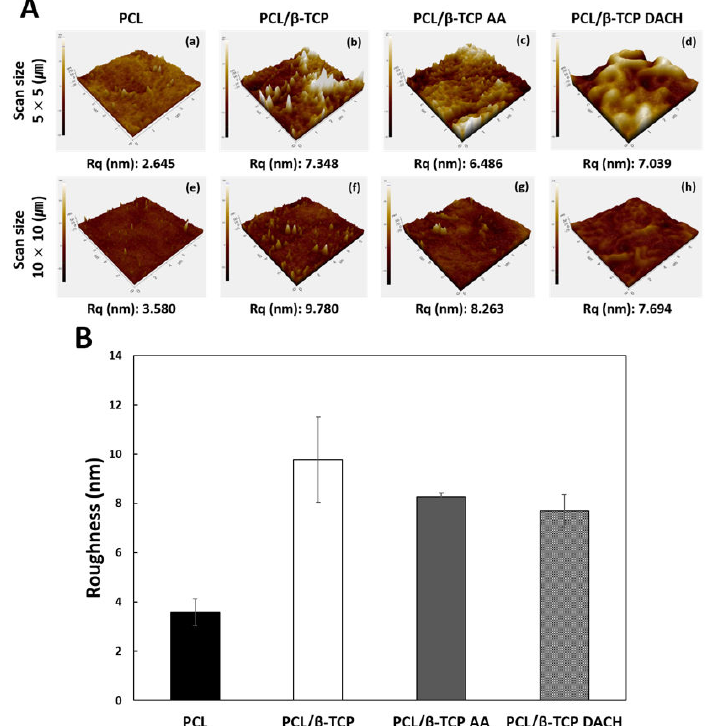
Figure 4. ( A ) Representative AFM 3D-topographical images of the ( a ) PCL scaffold, ( b ) PCL/ β -TCP scaffold, ( c ) PCL/ β -TCP scaffold treated by AA plasma for 1 min, ( d ) PCL/ β -TCP scaffold treated by DACH plasma for 1 min. For ( a – d ), the scan area = 5 × 5 µ m. For ( e – h ), the scan area = 10 × 10 µ m. ( B ) Roughness values of the PCL film, PCL/ β -TCP film, PCL/ β -TCP AA film, and PCL/ β -TCP DACH film ( n =